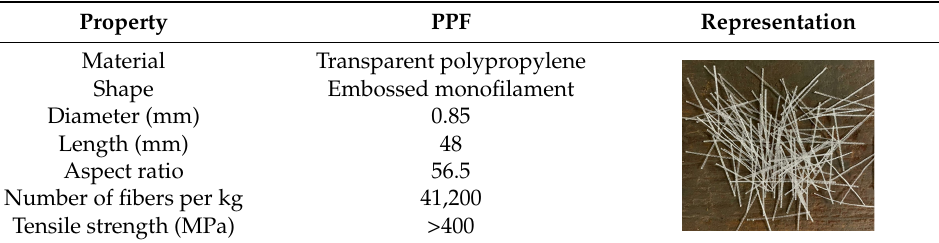
Table 1. Composition of studied MSFRC.